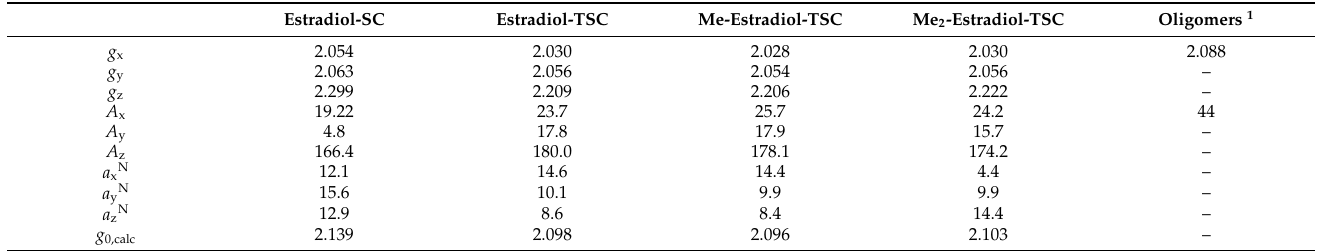
Table 4. Anisotropic EPR parameters obtained for the Cu(II) complexes of estradiol-(T)SC ligands by the simulation of frozen solution (77 K) EPR spectra recorded in 20% ( v/v ) MeOH/DMSO. The unit of the coupling values is 10 − 4 cm − 1 unit. The experimental errors were ± 0.002 for g x and g y , ± 0.001 for g z , ± 2 G for A x and A y , and ± 1 G for A z and nitrogen couplings. Isotropic values of the g -tensor are calculated via equation: g 0 = ( g x + g y + g z